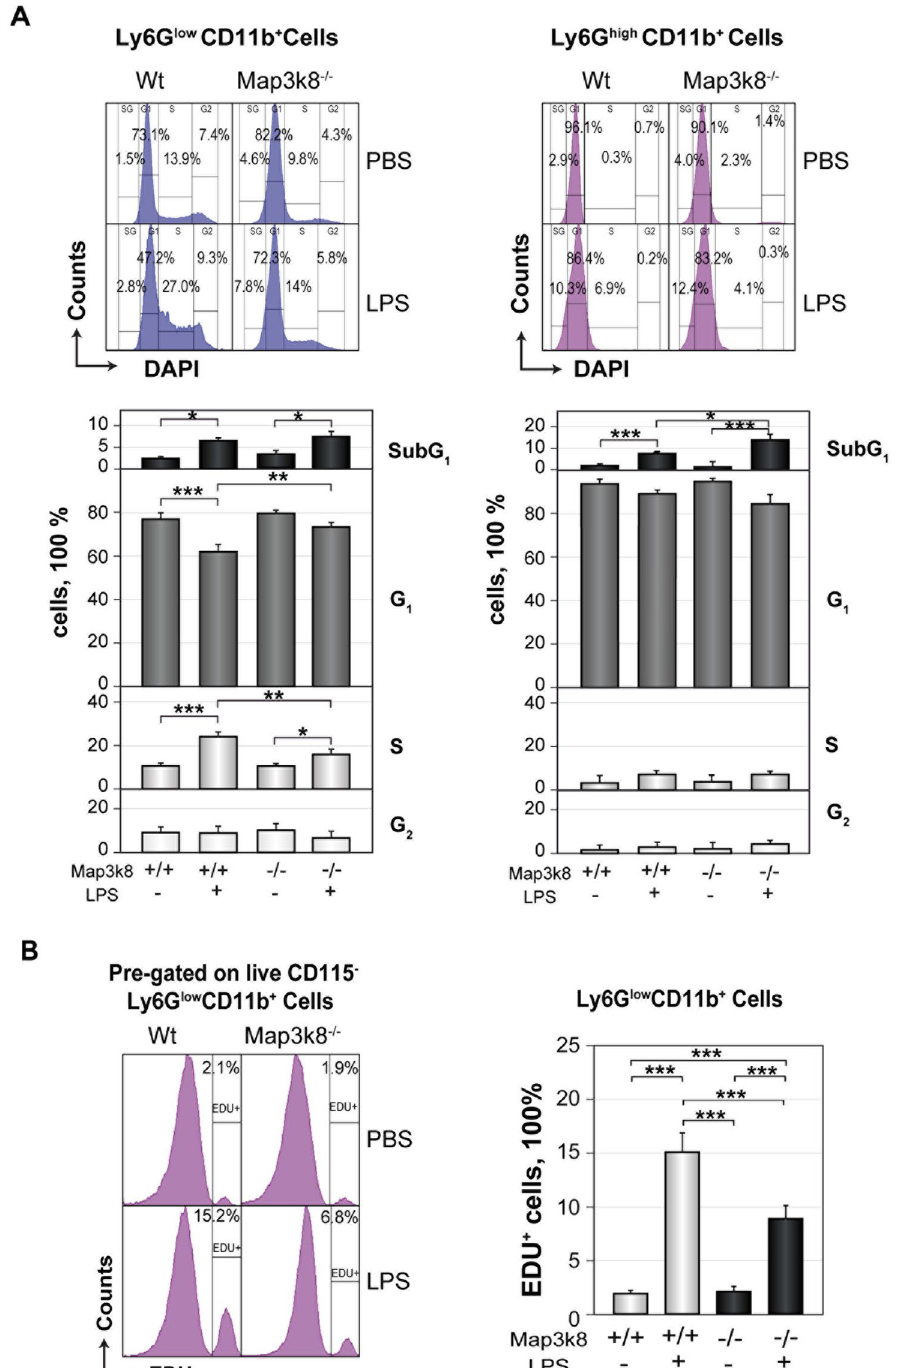
Figure 3. Map3k8 deficiency slows the cell cycle progression of BM Ly6G low CD11b + immature neutrophils in LPS-treated mice. ( A ) BM cells from Wt and Map3k8 − / − untreated and LPS-treated mice were surface- stained, permeabilized and stained with DAPI. Representative histograms depicting the cell cycle distribution of Ly6G low CD11b + immature and Ly6G high CD11b + mature neutrophils. The lower panels show the percentage of cells in the different phases of the cell cycle. Data from at least 3 independent experiments performed in duplicate are shown. ( B ) Another set of mice treated as in ( A ) received an injection of 2 ′ -deoxy-5- ethynyluridine (EDU) 18 h before they were killed. BM cells were surface-stained, permeabilized and subjected to the Click-iT ® reaction. Histograms depict a representative analysis of EDU-positive cells among the Ly6G low CD11b + immature neutrophil population. The graph on the right shows the frequency of EDU-positive cells among Ly6G low CD11b + immature neutrophils. Data from two independent experiments performed in triplicate are presented as the mean ± SEM. Newman-Keuls tests were used to compare groups. * p < 0.05, ** p < 0.01, *** p <